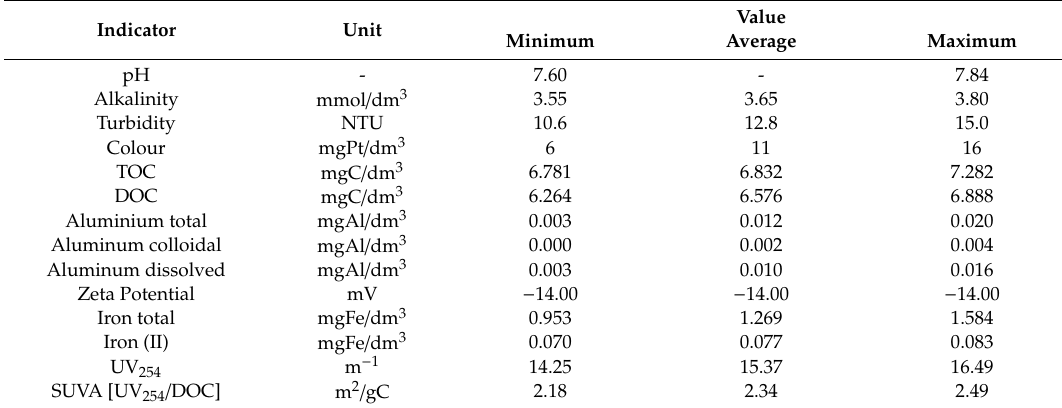
Table 2. Raw water quality